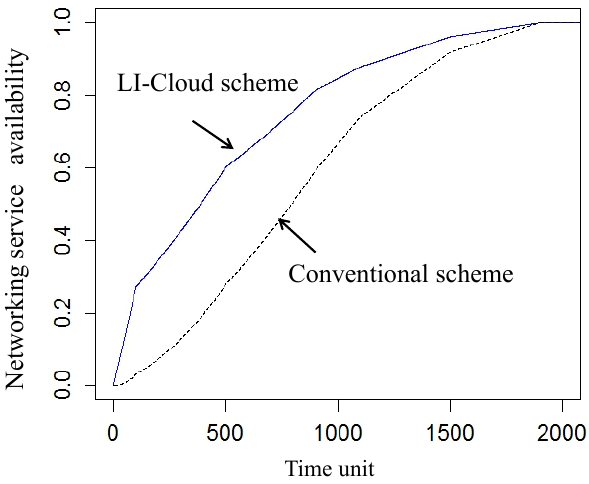
Figure 6. I-NSA for users in the scenario of sequential deployment of networking services with (uniform distribution of restoration. Ta, Tb, and Tc are set to 100, 500, and 900, and T AG , T BG , and T CG are set to 1100, 1500, and 1900, respectively).